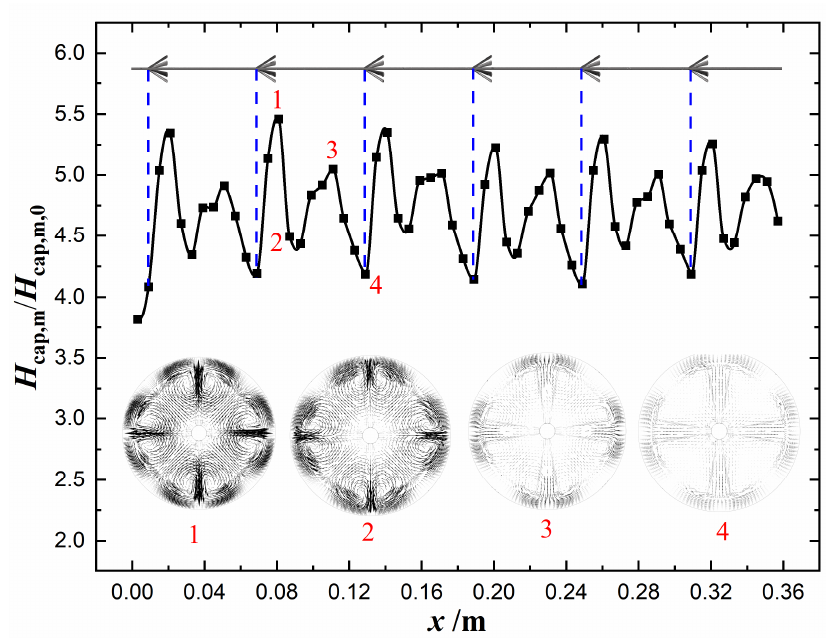
Nu Nu and f f along the tube at Re = 600. 0 0